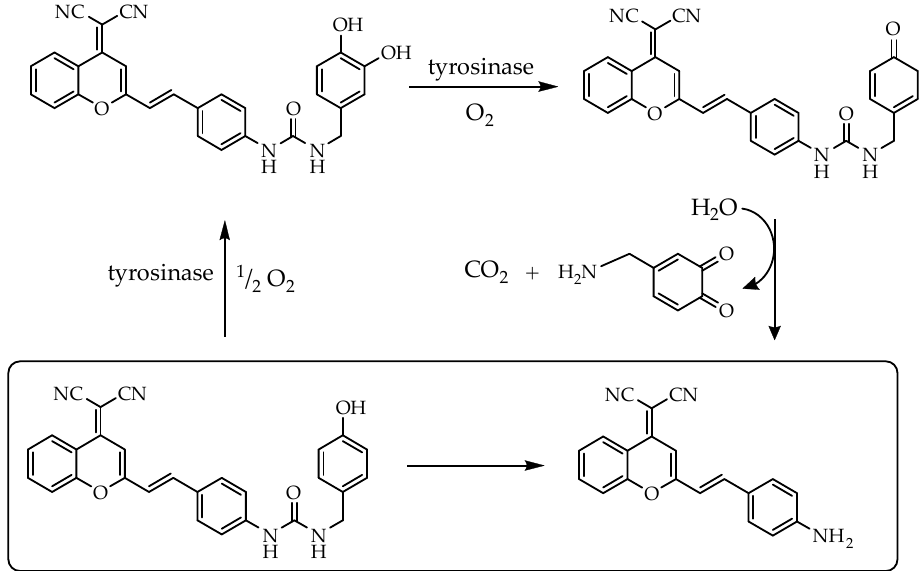
Scheme 2. Proposed sensing mechanism of DCM-NH 2 release by TYR.